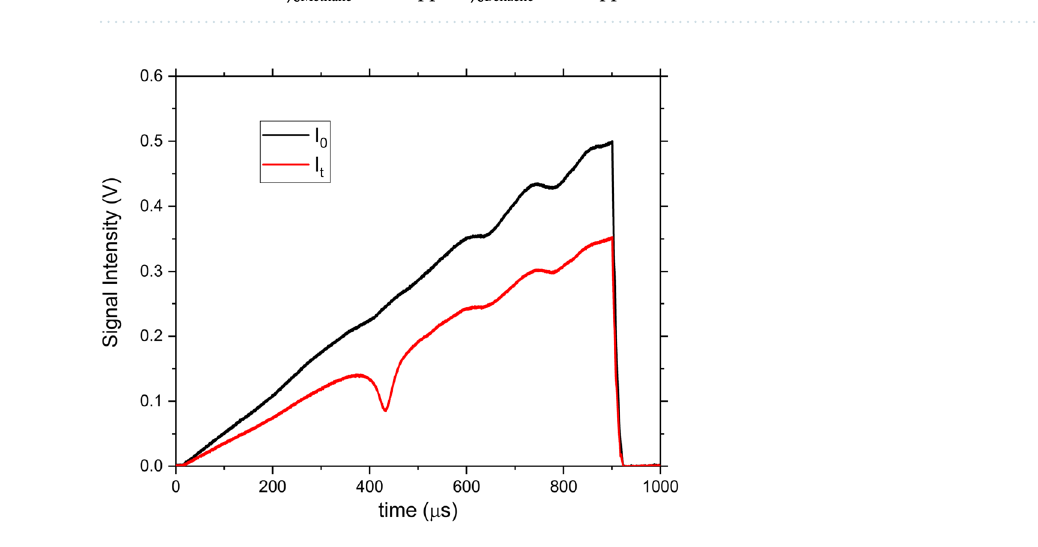
Figure 4. Composite measured and simulated absorbance spectra 51,52 over 3037–3039.5 cm −1 at T = 298 K,